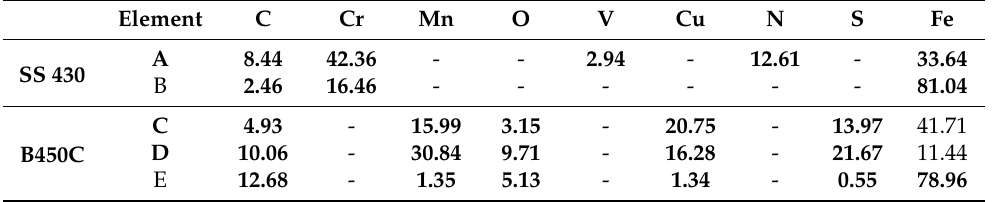
Figure 5. SEM images ( × 1000) of steel surfaces after removal of corrosion layers formed during exposure to chloride-containing cement extract solution for 720 h (30 days): ( a ) SS 430 and ( b ) zoom ( × 3000); ( c ) B450C and ( d ) zoom ( × 3000). Table 7. EDS surface analysis (wt.%) of SS 430 and carbon steel B450C after removal of corrosion layers formed during exposure to cement extract solution (+5 g L − 1 NaCl) for 720 h.